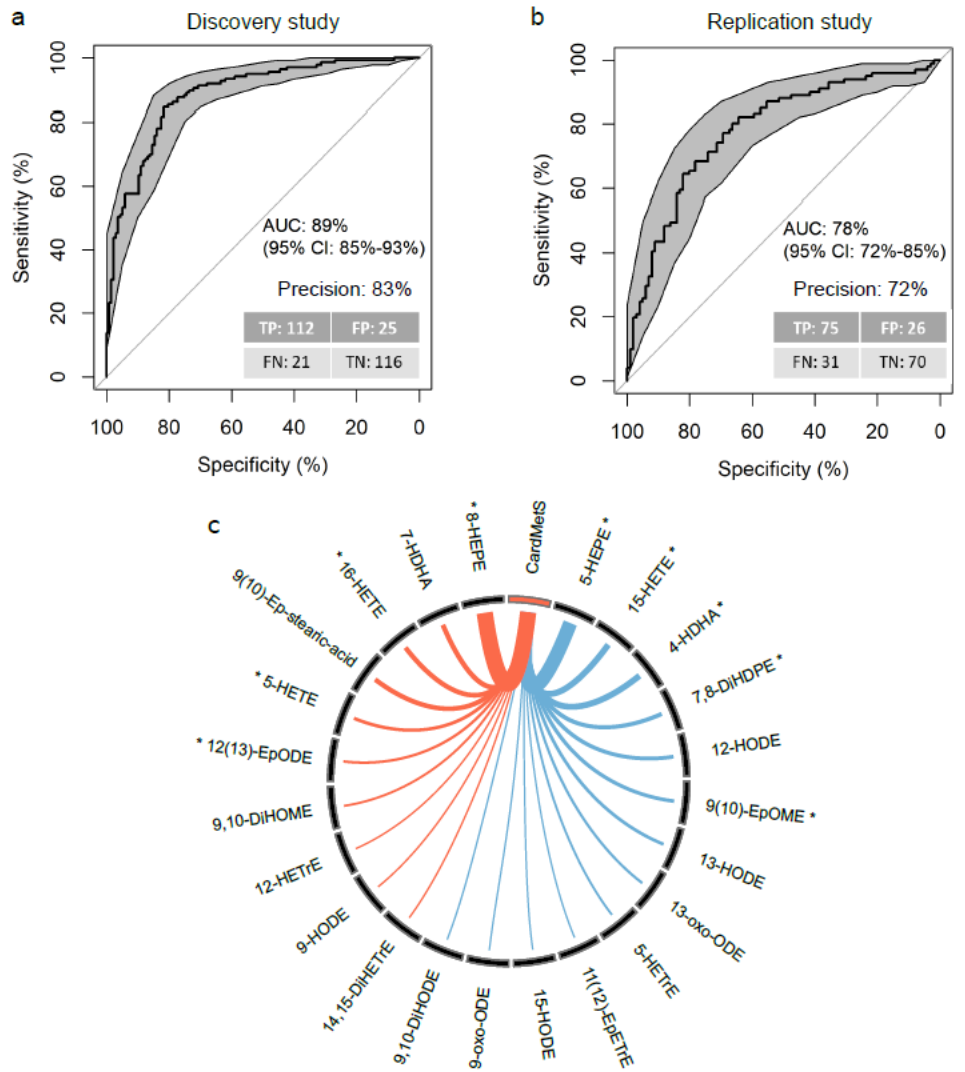
Figure 5. Optimization and external validation of the oxylipin signature of MetS. Based on the oxylipins selected in the Discovery and Replication cross-sectional studies ( n = 29 oxylipins), a LASSO-penalized conditional logistic regression model including 23 oxylipins was constructed with the participants in the Discovery study. The performances of the LASSO model were assessed in ( a ) the Discovery and ( b ) Replication cross-sectional studies using the Area Under the Receiver Operating Characteristic Curve (AUC and error rate were 10-fold cross-validated). Sensitivity is the percentage of Case correctly predicted (“True Positive”) and specificity is the percentage of Control correctly predicted (“True Negative”). TP: True Positive, FP: False Positive, TN: True Negative and FN: False Negative with Positive corresponding to CardMetS and Negative to Control. Circos plot ( c ) showing the odd ratios (OR) associated with each oxylipin selected in the LASSO model. * represents significant effect of oxylipins ( p < 0.05) in the LASSO model. OR are for 1SD-increment of oxylipin absolute concentration. Line colors indicate if OR are >1 (orange) or <1 (blue). Line thickness represent the relative values of OR in the model.